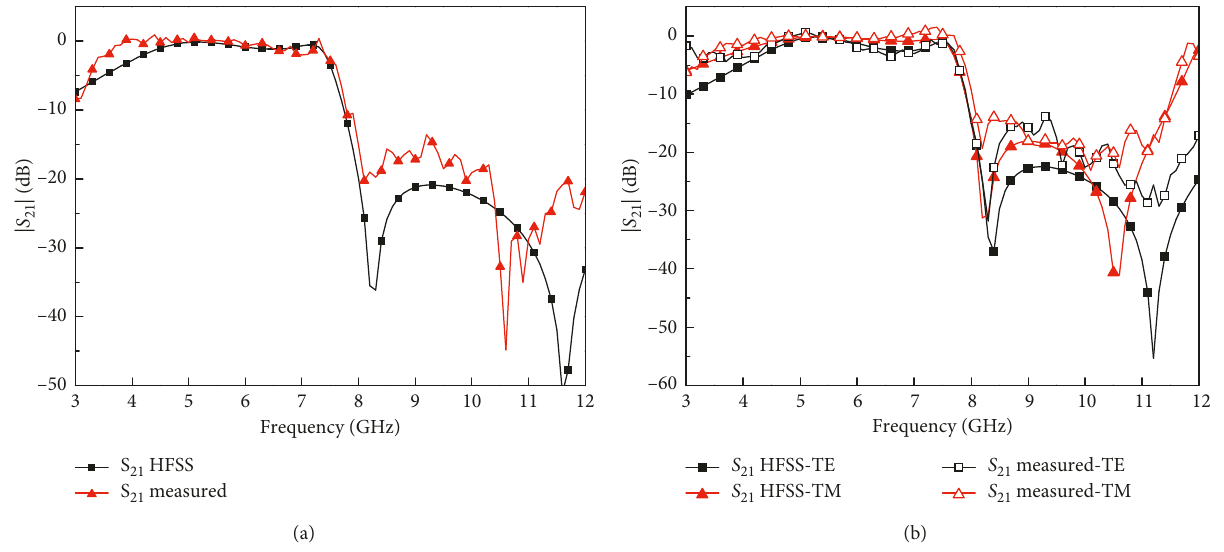
Figure 14: Comparison of the measured and the simulated results. (a) | S θ � 45 °